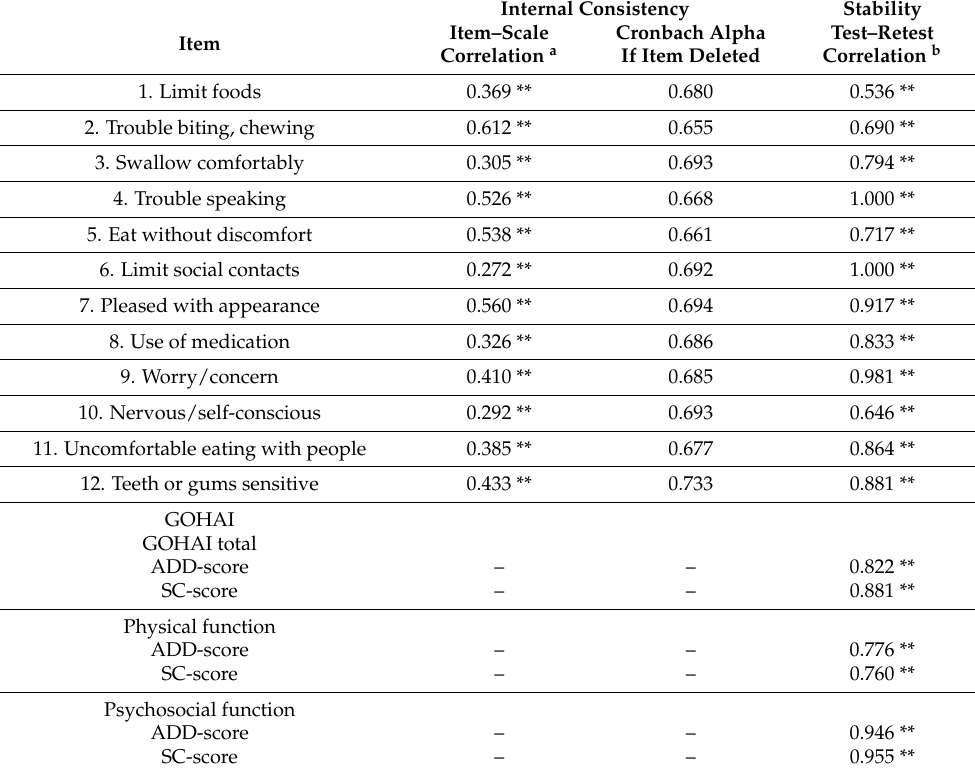
Table 3. Item–scale correlation, Cronbach’s alpha if item deleted and test–retest-correlation for single items and GOHAI ADD-scores, GOHAI